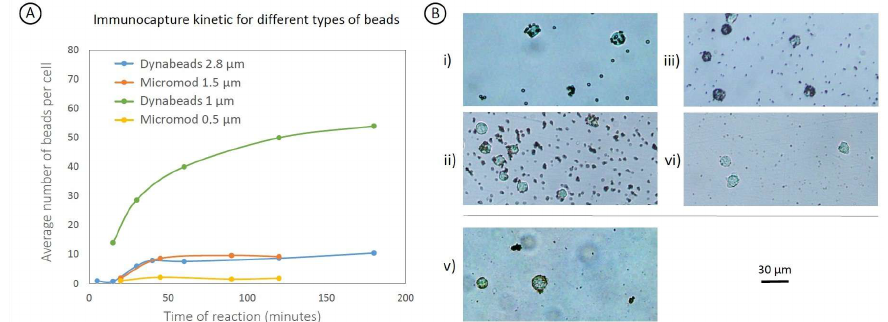
Figure A1. ( A ) Kinetic of NS1 labeling for 4 types of microbeads. ( B ) 20 magnification photographs of NS1 cells incubated 2 h with: (i) Dynabeads 2.8 µ m (ii) Micromod 1.5 µ m (iii) Dynabeads 1 µ m (iv) Micromod 0.5 µ m (v) Adembeads 200